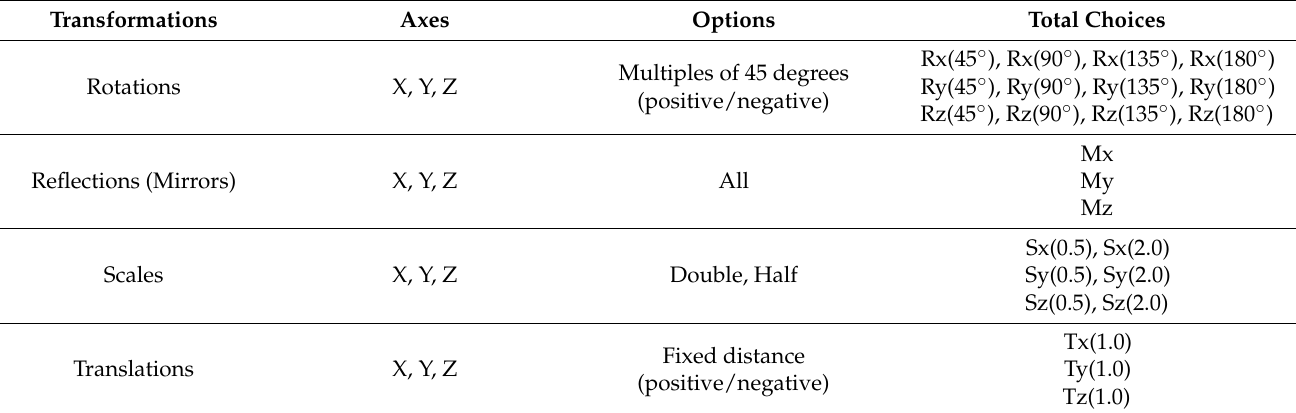
Table 1. Geometric transformations selected.